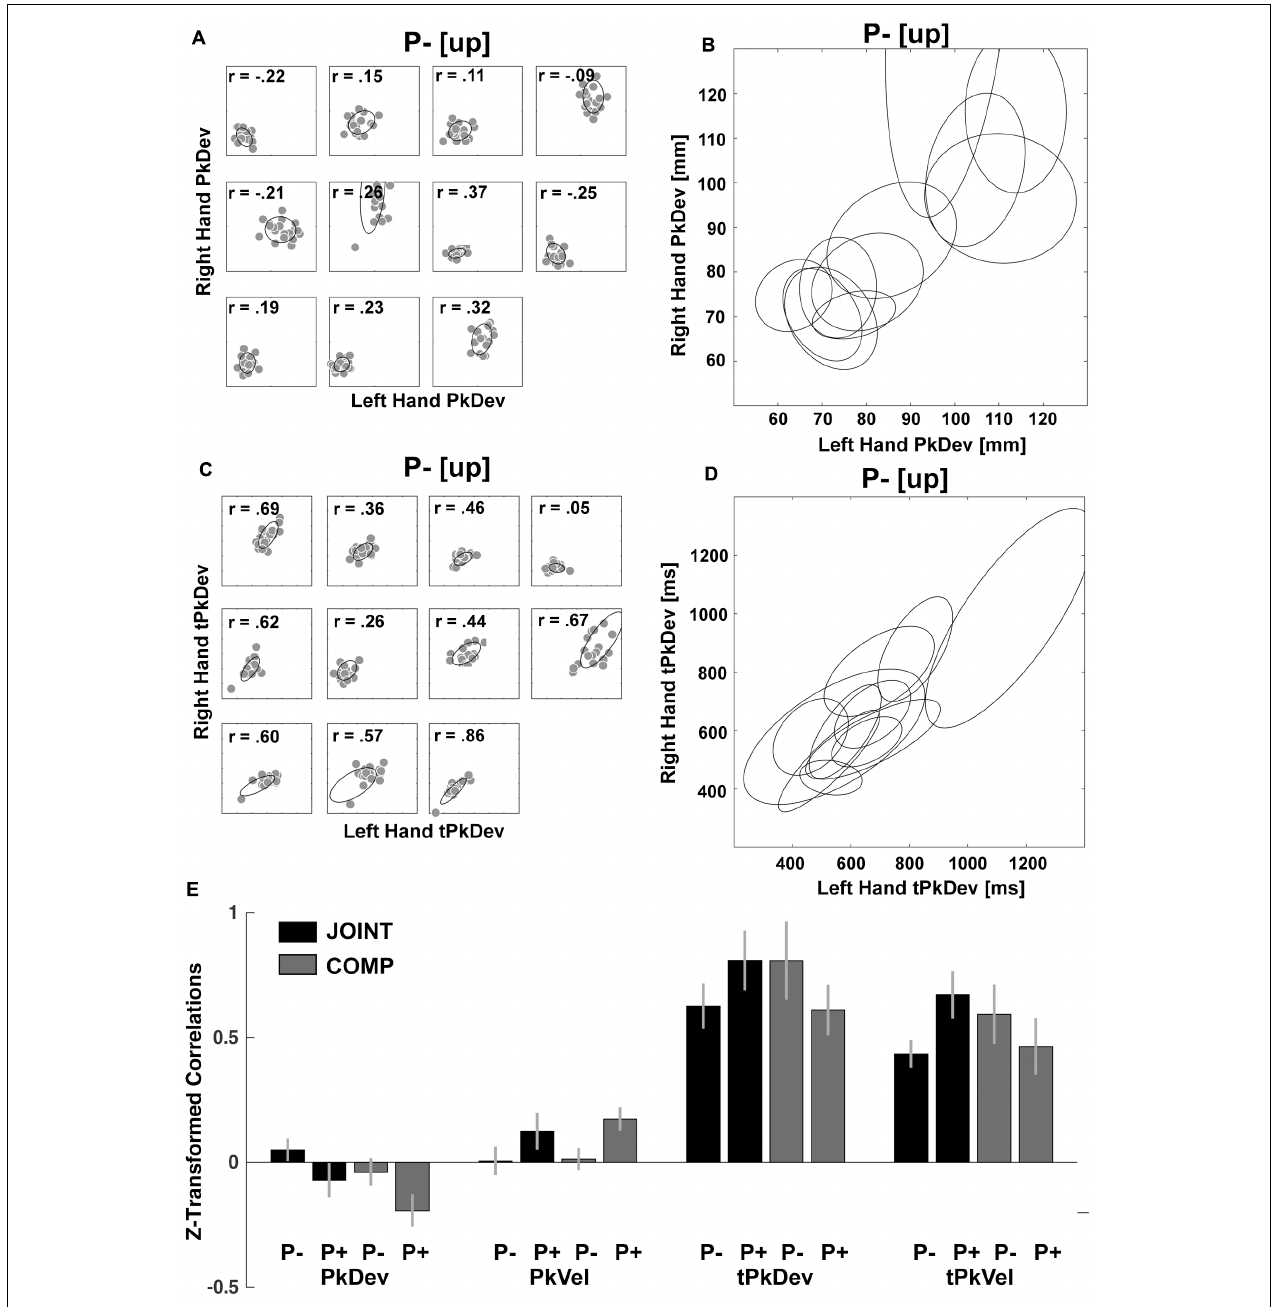
FIGURE 6 | Within-dyads correlations. (A) Scatterplots of each dyad’s PkDev in JOINT P– [up rotation condition] with fitted ellipses. (B) PkDev ellipses from all dyads. (C) Scatterplots of each dyad’s tPkDev in JOINT P– [up rotation condition] with fitted ellipses. (D) tPkDev ellipses from all dyads (for ellipse fitting method